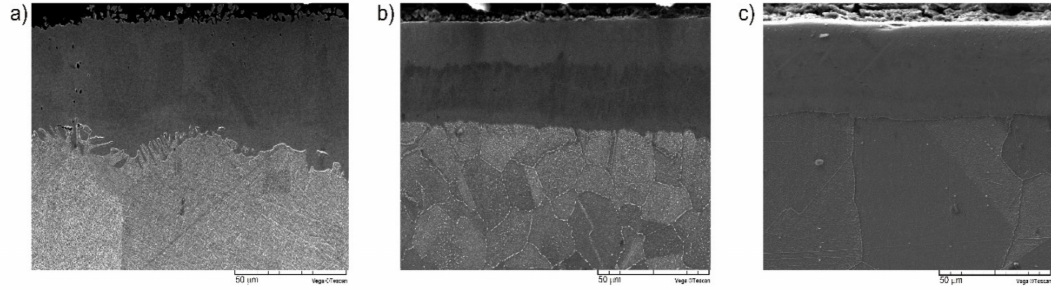
Figure 2. The SEM image of borided layers produced on: ( a ) Nickel 201, ( b ) Inconel ® 600 alloy and ( c ) Nimonic ® 80A